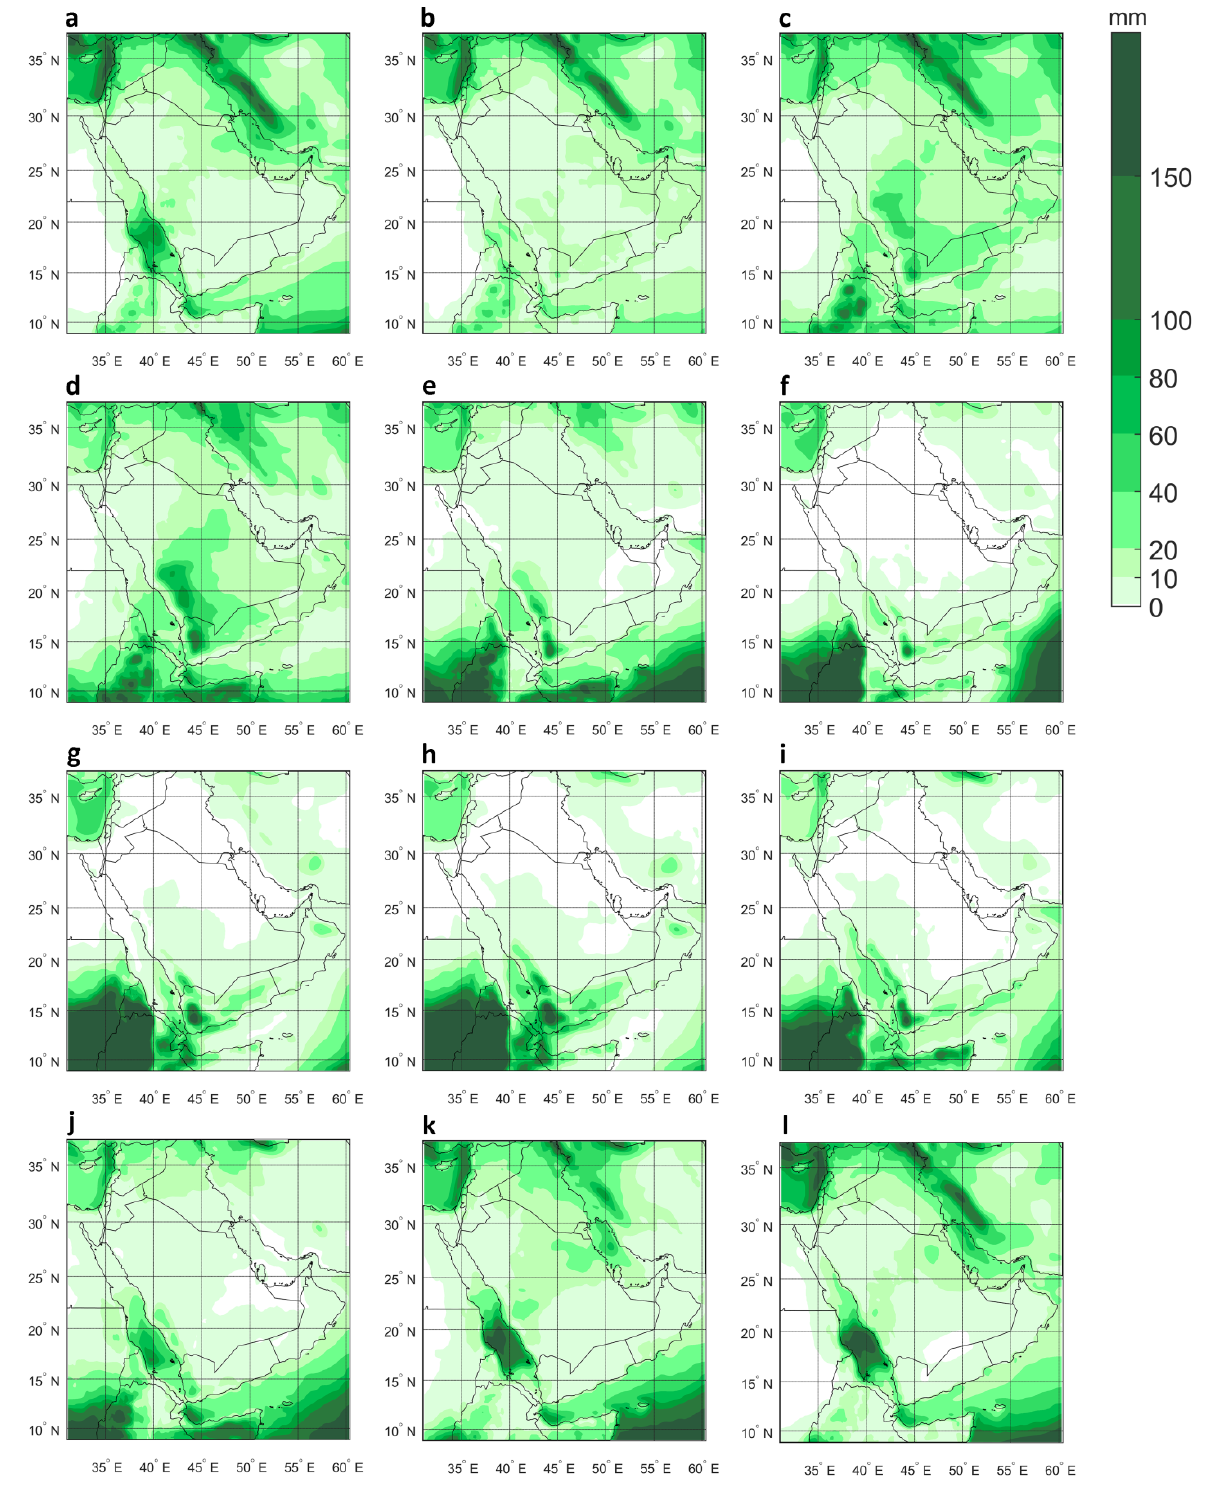
Figure 8. Mean monthly accumulated precipitation (modeled) for ( a ) January, ( b ) February, ( c ) March, ( d ) April, ( e ) May, ( f ) June, ( g ) July, ( h ) August, ( i ) September, ( j ) October, ( k ) November and ( l )